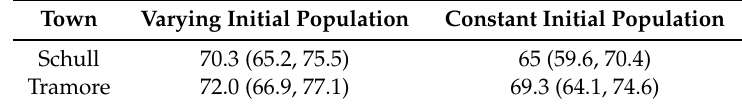
Table 2. Percent of runs leading to an outbreak for a steady versus a varying initial population.